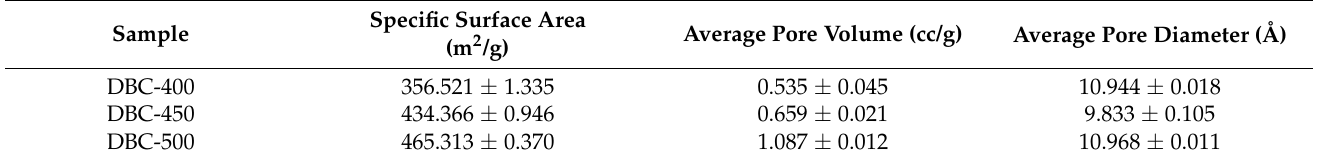
Table 3. Electron Microscopy Analysis of DBC